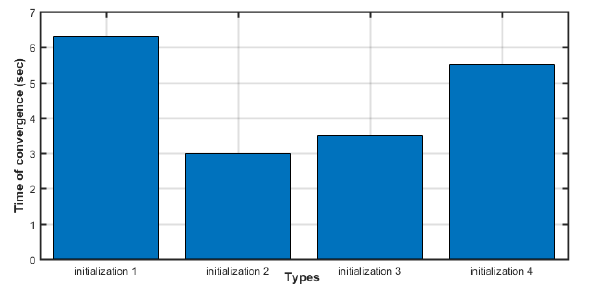
Fig. 8. Time of convergence of the gradient descent in each initialization